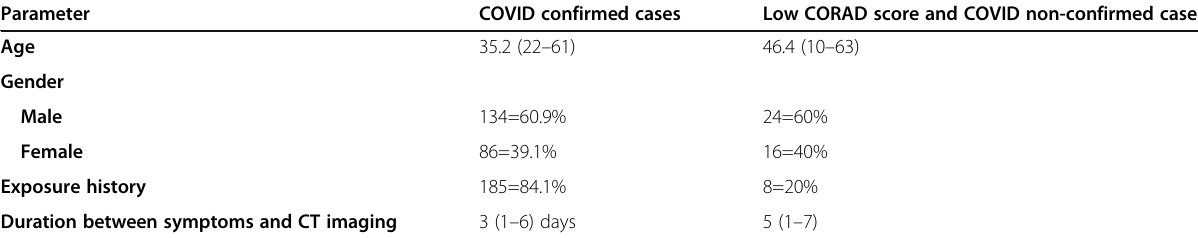
Table 1 Demographic data of the cases